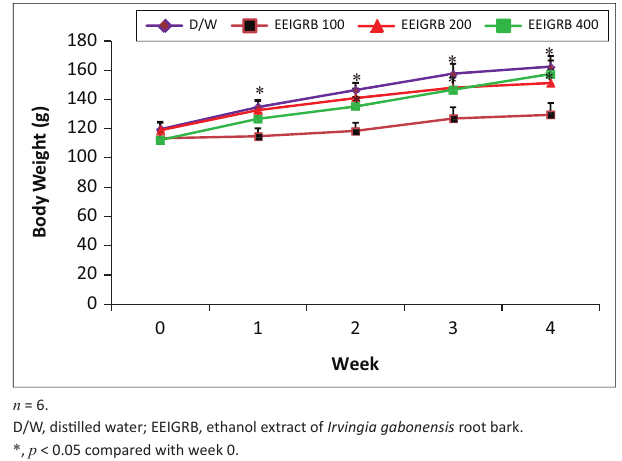
FIGURE 1: Effect of 28 days of oral administration of ethanol extract of I. gabonensis root bark on body weights of rats. Values are presented as mean ± standard error of mean. Repeated measure analysis of variance followed by Bonferroni post hoc